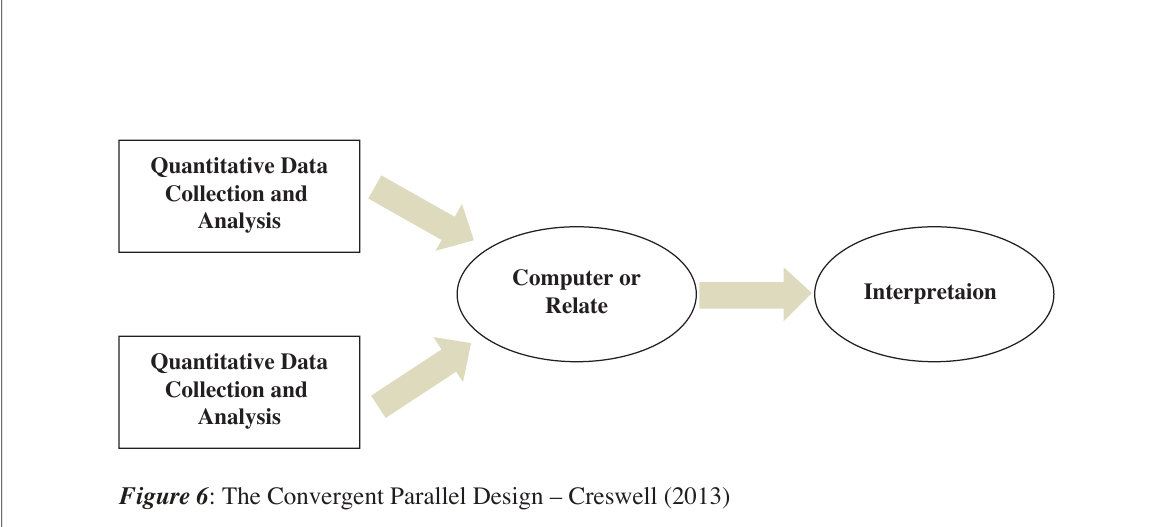
Figure 6 : The Convergent Parallel Design – Creswell (2013)